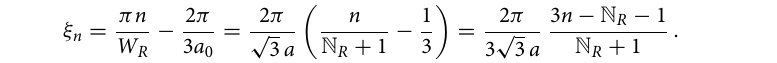
Figure 1. Schematic illustrations for three sublattices ( A , B , H ) of α ( a ) and ( b ) depict representations of a nanoribbon with armchair termination for defining the width W R of a nanoribbon with inter-atom distance a and lattice constant a 0 . Panel ( c ) demonstrates the edge-row configurations and transverse boundary conditions along the x axis for an armchair edge of α lattice, where the letters H , A , B label hub and hexagonal-rim atoms of two sublattices. Panel ( d ) illustrates the first Brillouin zone and the wave vectors K and K ′ of two